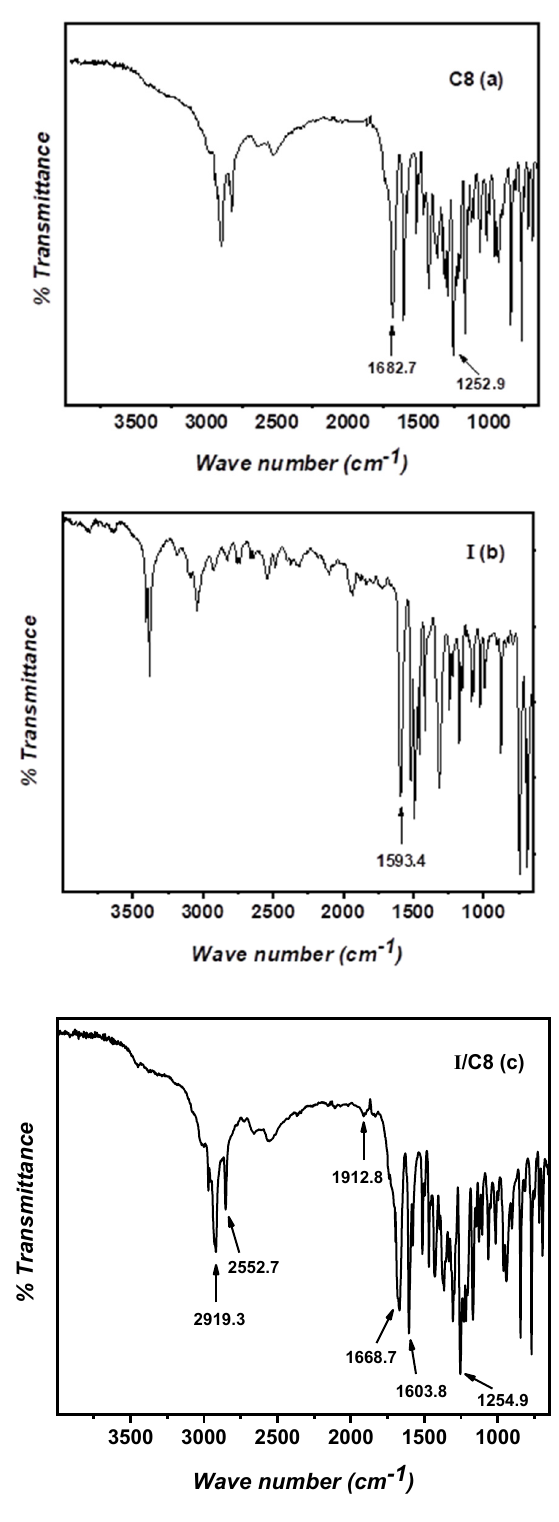
Figure 1. ( a – c ) FT-IR spectra of para-octyloxy benzoic acid ( C8 ), the methyl Schiff base ( I ), and the complex I/C8 in charts ( a – c ), respectively.